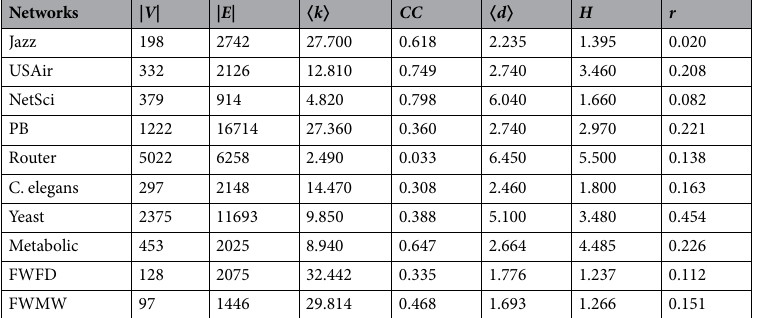
Table 1. The basic topological features of ten real networks studied in this paper, where | V | and | E | are the numbers of nodes and links, 〈 k 〉 is the average degree, CC is the clustering coefficient and 〈 d 〉 is the average shortest distance. H is the degree heterogeneity, as = H k